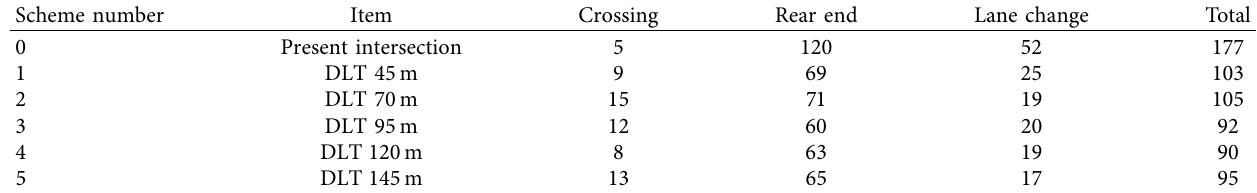
Table 6: Safety analysis of the six simulations by the surrogate safety assessment model (SSAM). Scheme number